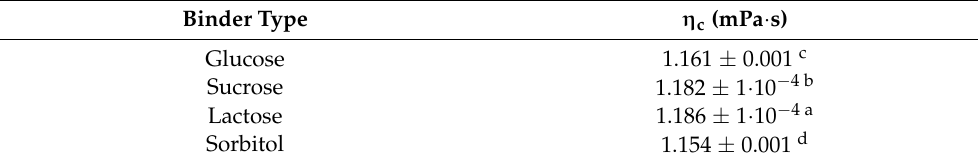
Values are means of triplicate measurements ± SD. Means with different lowercase letters (a–d) within each column are significantly different ( p <